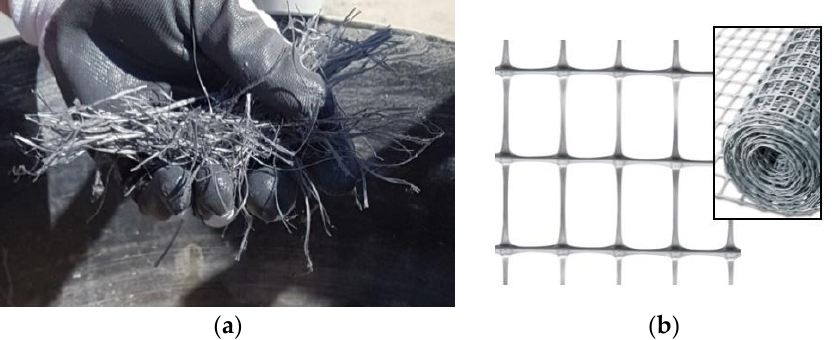
Figure 6. ( a ) Polypropylene fibers used for the panel reinforcement. ( b ) Polypropylene netting used for the panel reinforcement (spacing 30 mm × 45 mm).